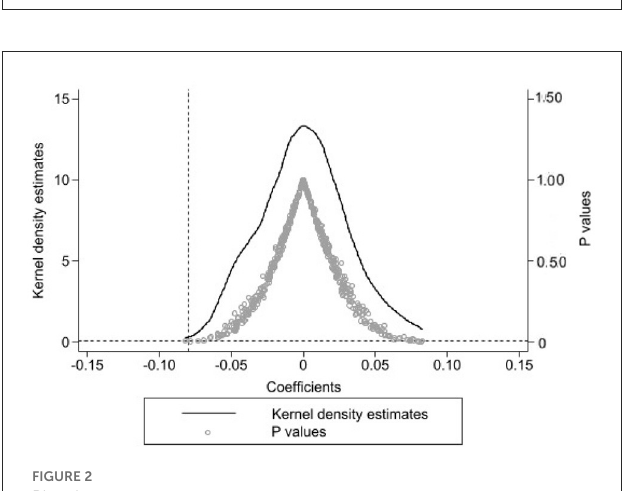
FIGURE1 Parallel trend test.